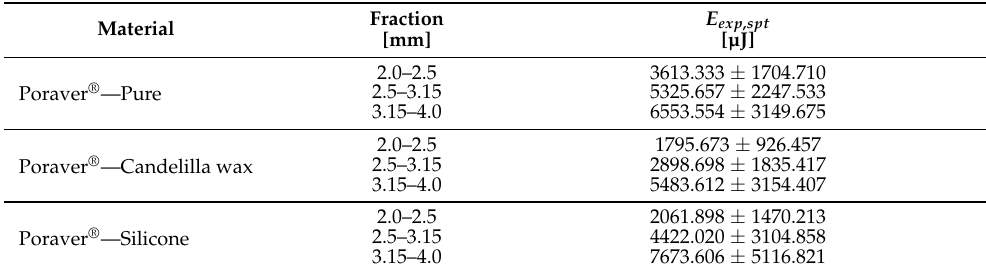
Table 3. Energy absorbed by uncoated and coated particles in single-particle compression tests for all diameter